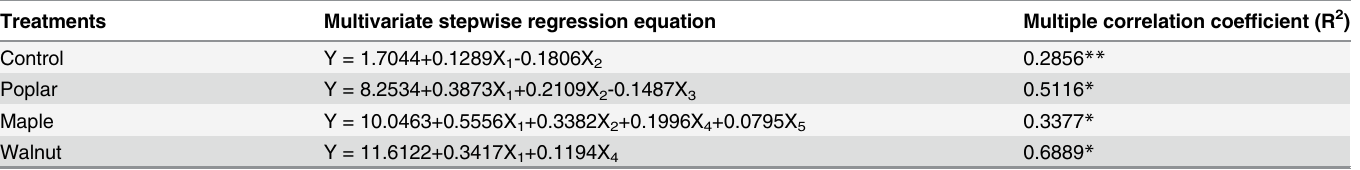
Table 5. Multiple regression analysis of environmental factors and photosynthetic rates of soybean in different treatments in 2012.